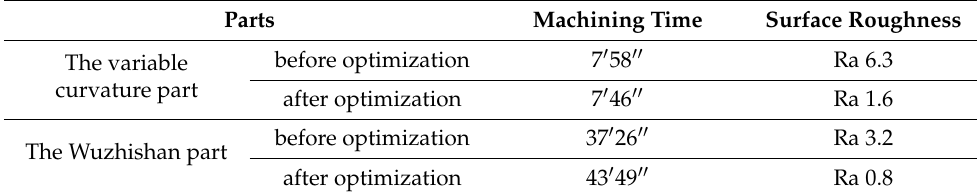
( b ) Figure 15. Machining comparison of Wuzhishan transition surface ( a ) before optimization ( b ) after optimization.